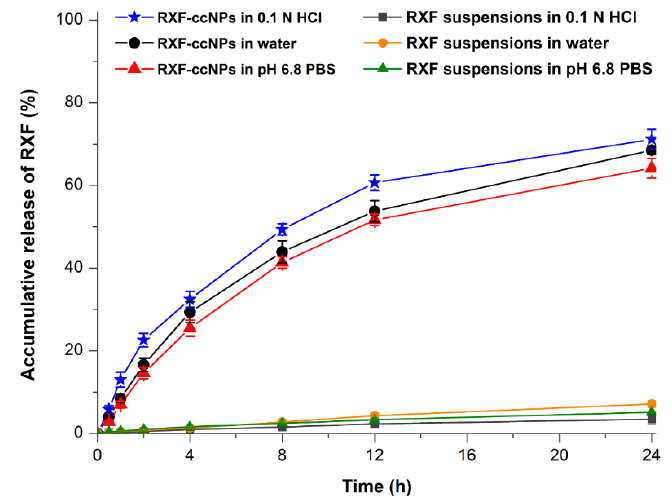
Figure 4. Release curves of RXF from RXF-ccNPs performed in water, 0.1 N HCl and pH 6.8 PBS based on in situ release method ( n = 3, mean ± SD).